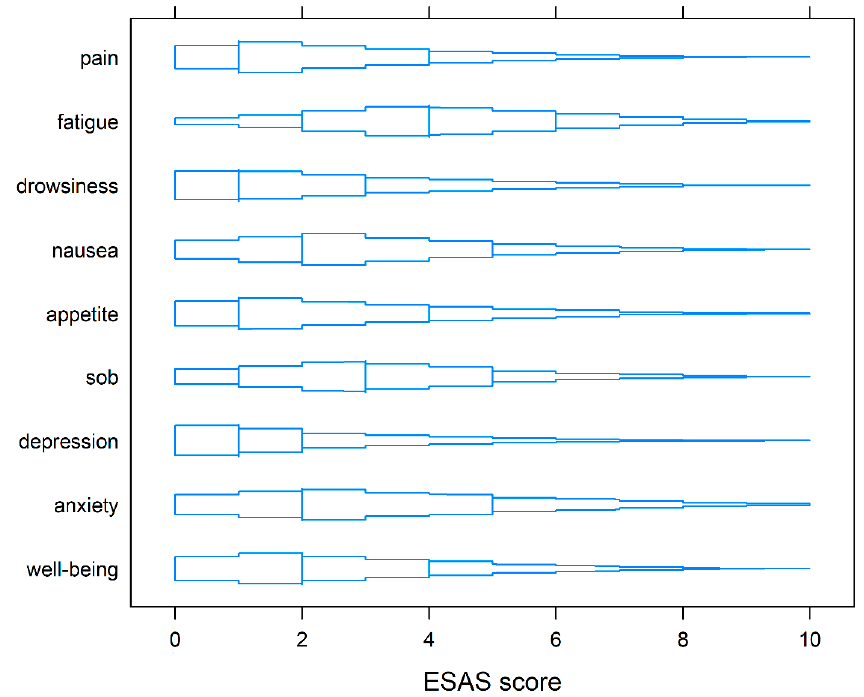
Figure 1. Box-percentile plots of symptoms on ESAS-r at baseline. Similar to boxplots, the median, 25th, and 75th percentiles are indicated with line segments across the box. Up to the median, the width indicates the percentile of that height. Beyond the median, the width indicates 100% minus the percentile. Table 2. Most common moderate-to-severe symptoms at